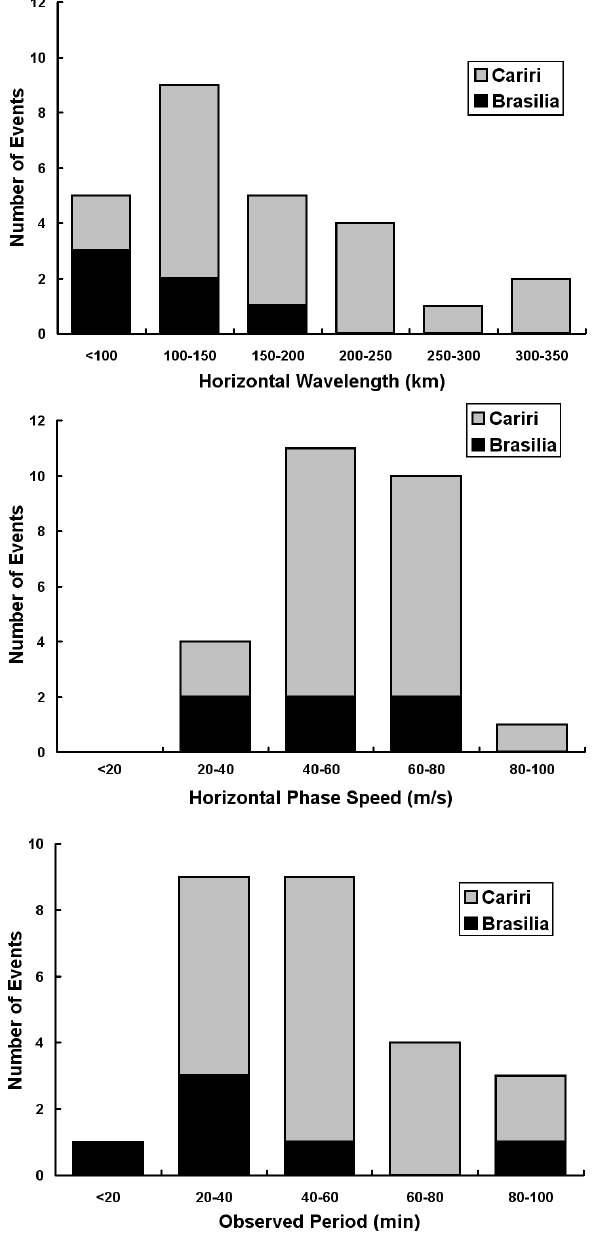
Fig. 7. Histograms showing the combined Brasilia and Cariri medium-scale wave characteristics.